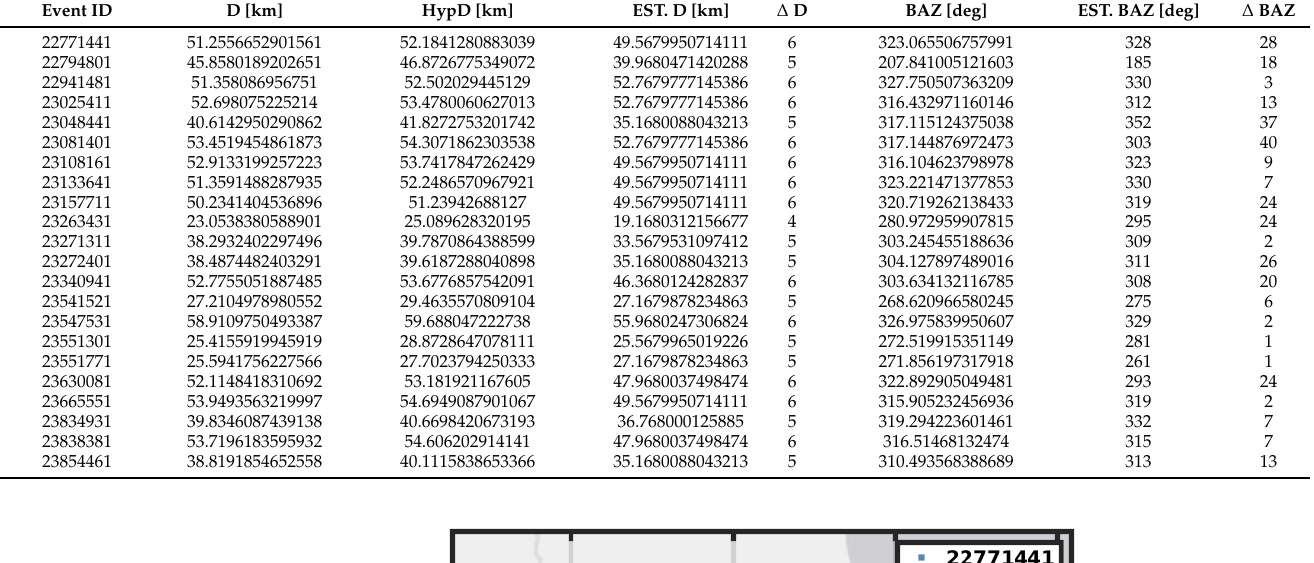
Table 3. Results and comparison for distance and backazimuth estimation.